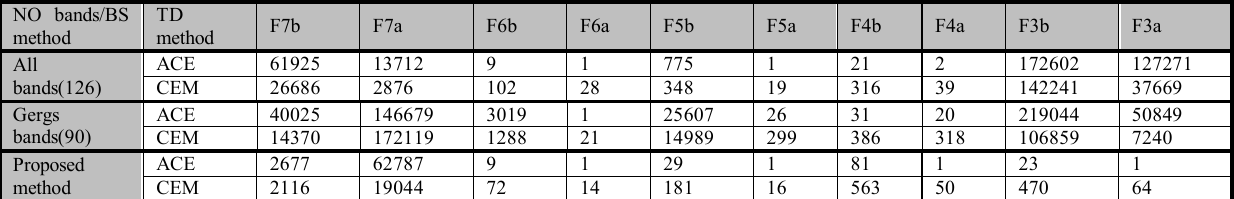
Table 2. Number of false alarms obtained for detecting the